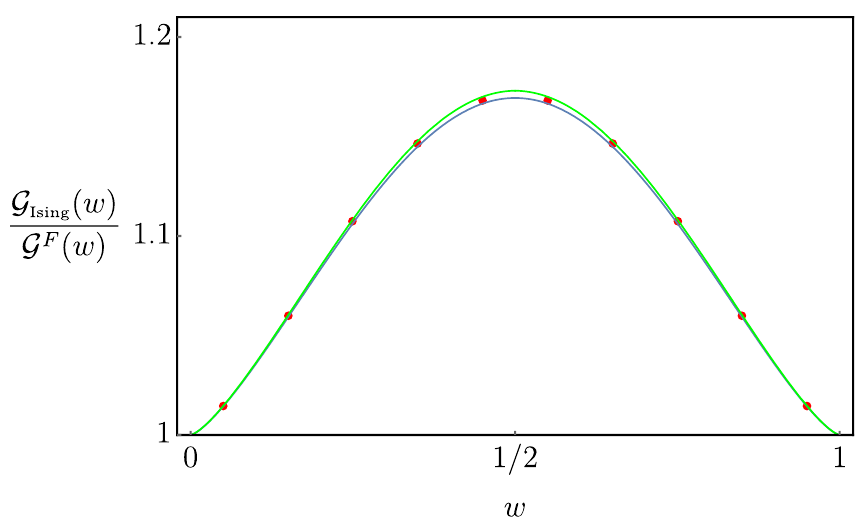
Figure 4 . Comparison between the 3d Ising spin field correlator and its approximations. The results are normalized relative to the generalized free fermion correlator G F ( w ) . The blue line (the lowest) is the correlator as computed from the conformal block expansion up to dimension 10. The red dots represent the two Polyakov block approximation of section 7. The green line is the identity interacting Polyakov block described in the text, computed from its conformal block